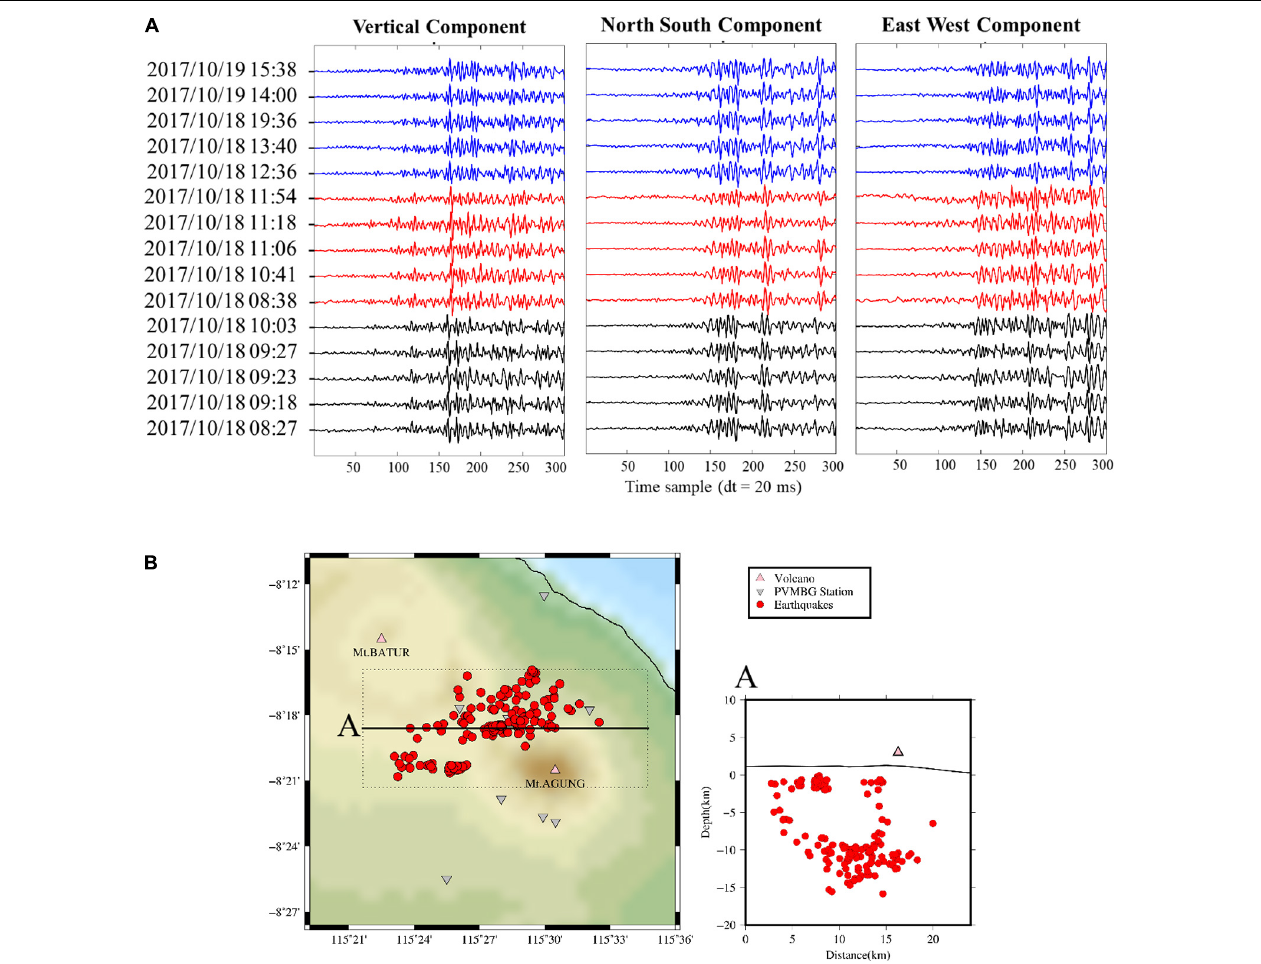
FIGURE 12 | (A) Example of waveforms of events belonging to the same cluster recorded at the same seismographic station. The three components of the seismographic stations are plotted. Clusters were determined based on waveform similarity. Events with waveform similarity of higher than 0.9 are clustered together. (B) Distribution of VT events which have high waveform similarity are plotted in map view and vertical section. All events with high waveform similarity occurred in October